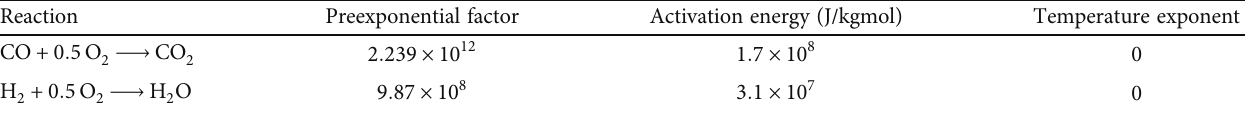
Table 2: Chemical reaction mechanism.